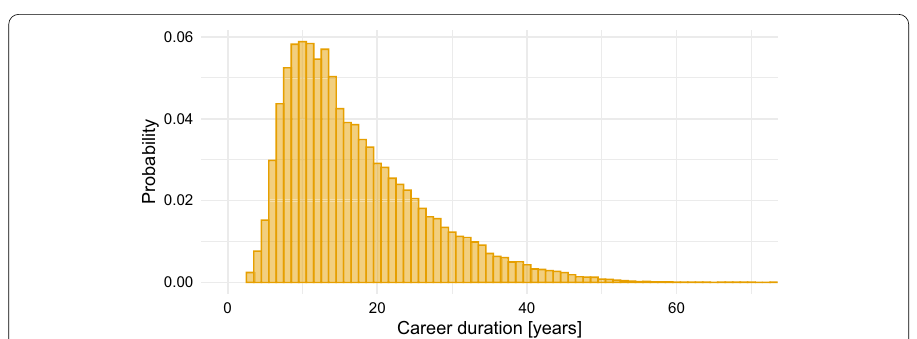
Fig. 3 Career duration distribution. The average career duration is 17.2